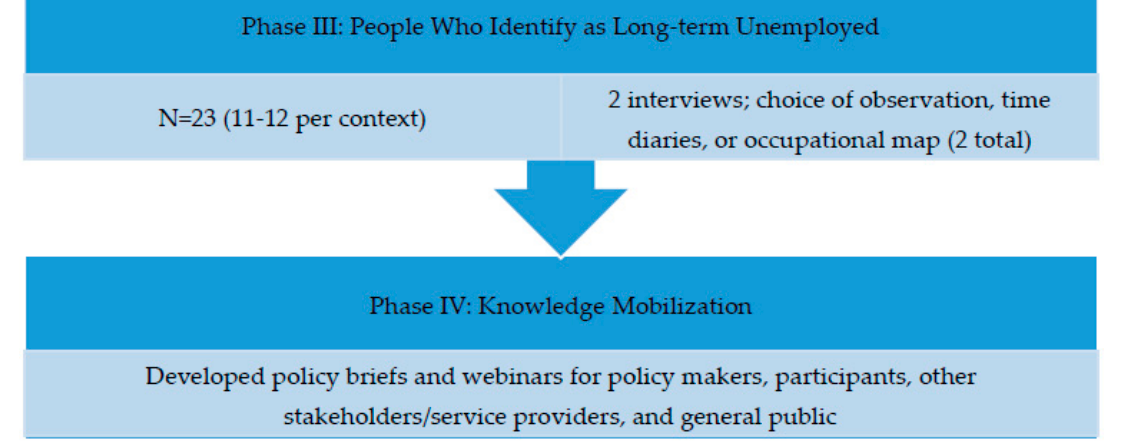
Table 1. Phases I and II participant information.